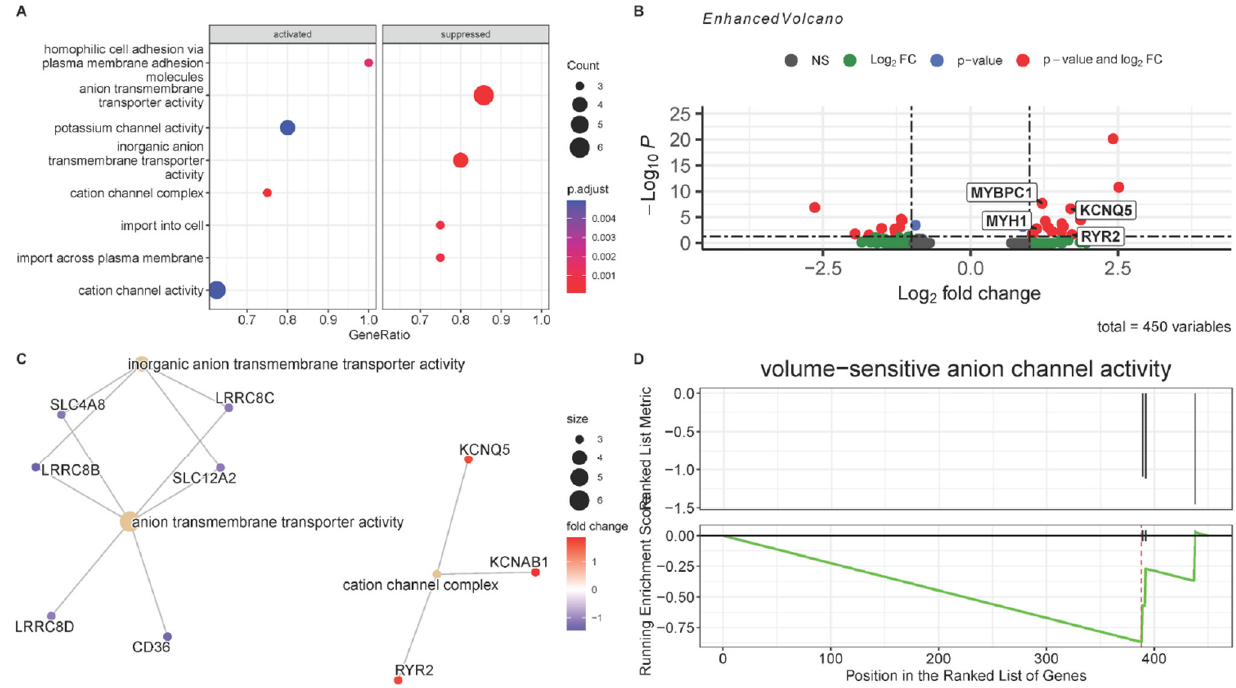
Figure 4. Functional enrichment analysis of VSMCs and VSMC-specific expression change of DMD mut and WT muscles. ( A ) Dot plot representing the top 4 gene ontologies (GOs) with the largest gene ratios in order of gene ratio. The color gradient of dots represents the adjusted P values, while the size represents the number of genes in the significant DEG list associated with the GO term. ( B ) Volcano plots showing the adjusted P values and the log2 fold change (FC) value of genes in the VSMCs from DMD mut and WT muscles. DEGs, indicated by the red dots, were identified as genes with an adjusted p ‐ value of ≤ 0.05 and |log2FC| > 0.26. KCNQ5, RyR2, MYH1, and MYBPC1 were indicated by the square. ( C ) The cnetplot depicts the linkages of genes and GO terms as a network, which is helpful to see which genes are involved in enriched pathways. ( D ) GSEA Plot of the Running Enrichment Score (green line) for a gene set as the analysis walks down the ranked gene list, including the location of the maximum enrichment score (the red line). The black lines in the Running Enrichment Score show where the members of the gene set appear in the ranked list of genes, indicating the leading edge